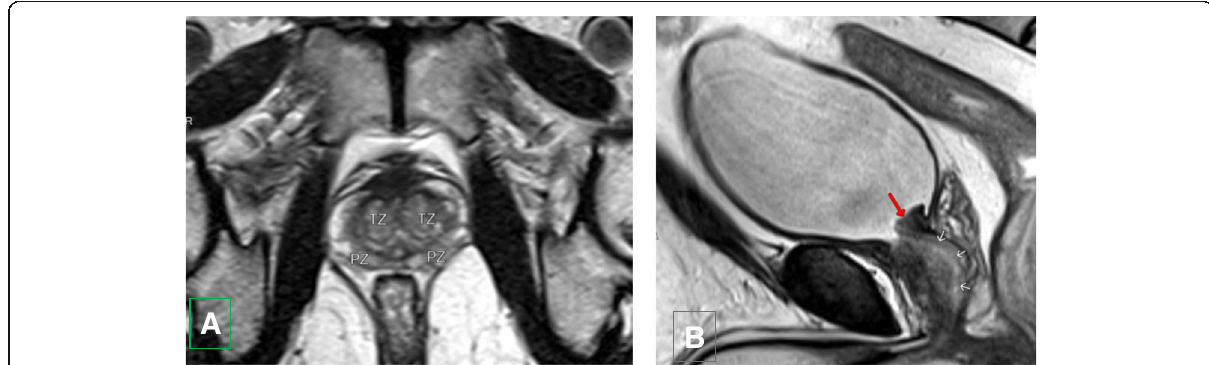
Fig. 6 Sixty-three years old man type 5 BPH. a Axial T2 WI showing bilateral transition zone (TZ) (lateral lobe) enlargement. Peripheral zone (PZ) is noted. b Sagittal T2 WI showing pedunculated enlargement (red arrow) protruding into the bladder base. No retrourethral (median) lobe enlargement along the posterior aspect of the prostatic urethra